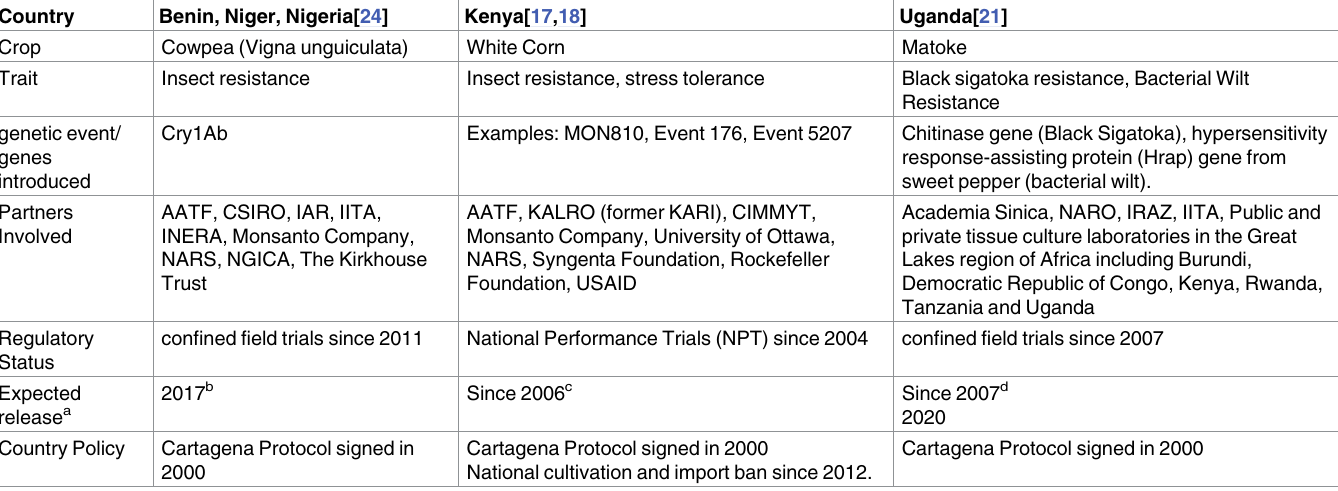
Table 1. Status of crops considered.